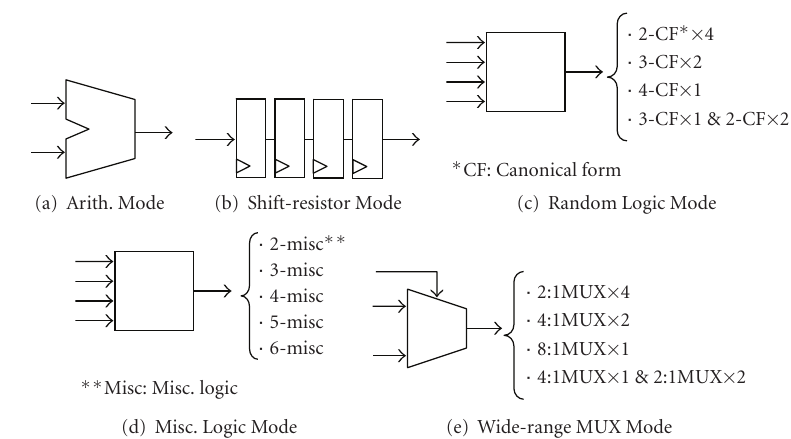
Figure 5: Variable grain logic cell architecture.